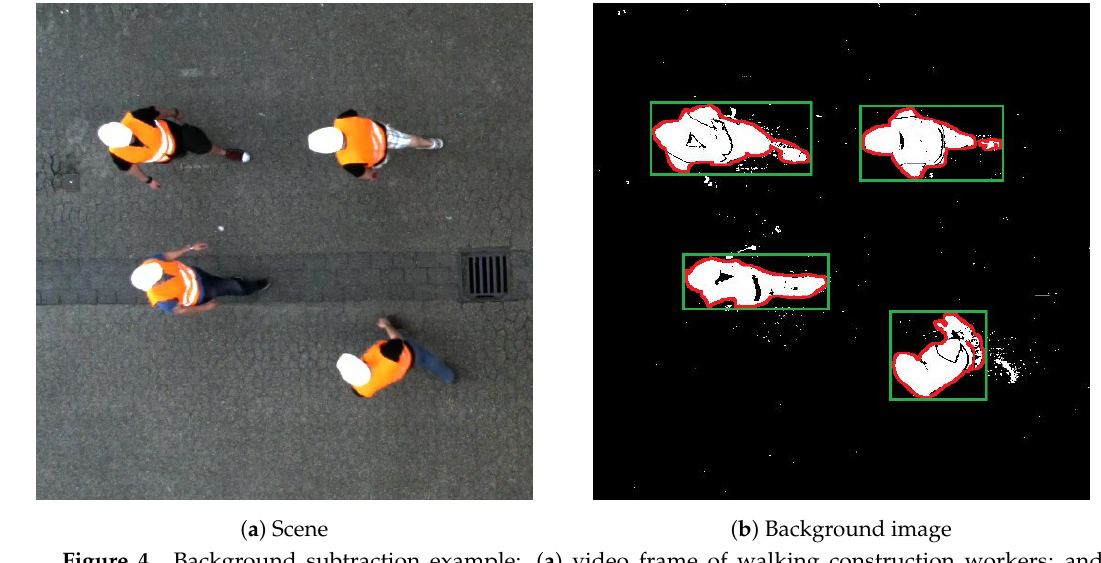
Figure 4. Background subtraction example: ( a ) video frame of walking construction workers; and ( b ) background image with white foreground pixels aggregated to blobs of motion (red) and the corresponding RoIs (green) for further